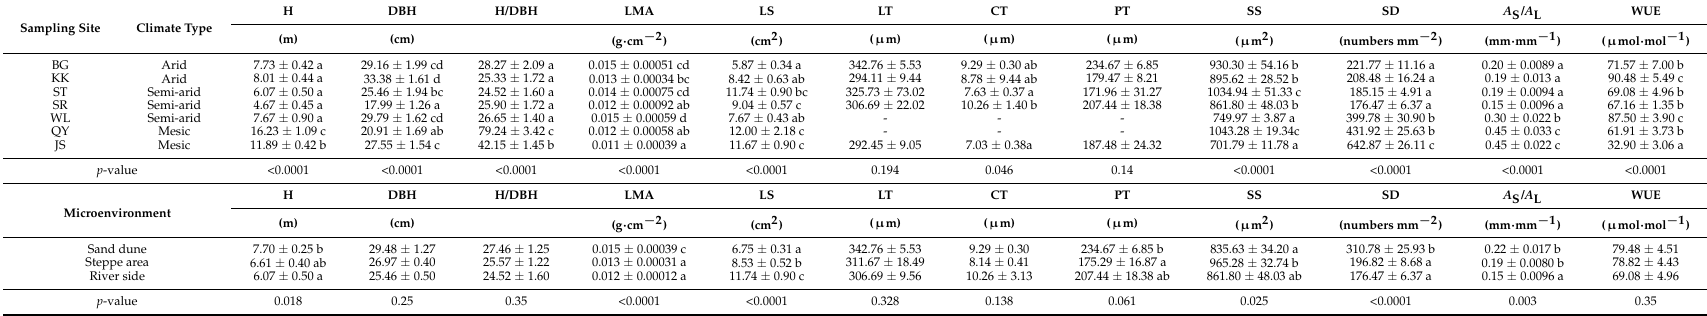
Table 2. ANOVA for the growth, leaf traits and WUE characteristics of the Siberian elm in the seven study sites and three types of microenvironments.